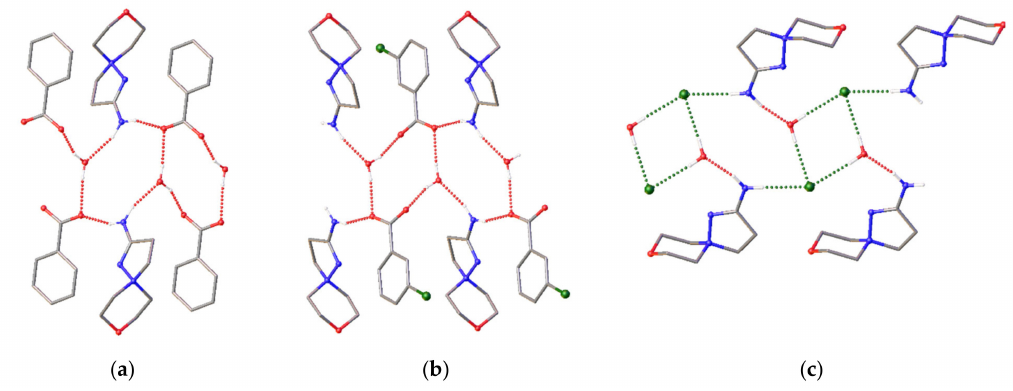
Figure 5. Fragment of H-bonded chains in the crystal of ( a ) 5c , ( b ) 5e , ( c ) 6 . Color code: C—grey, Cl—green, H—white, N—blue, O—red. The H(C) atoms are omitted. Intemolecular interactions are shown with dotted